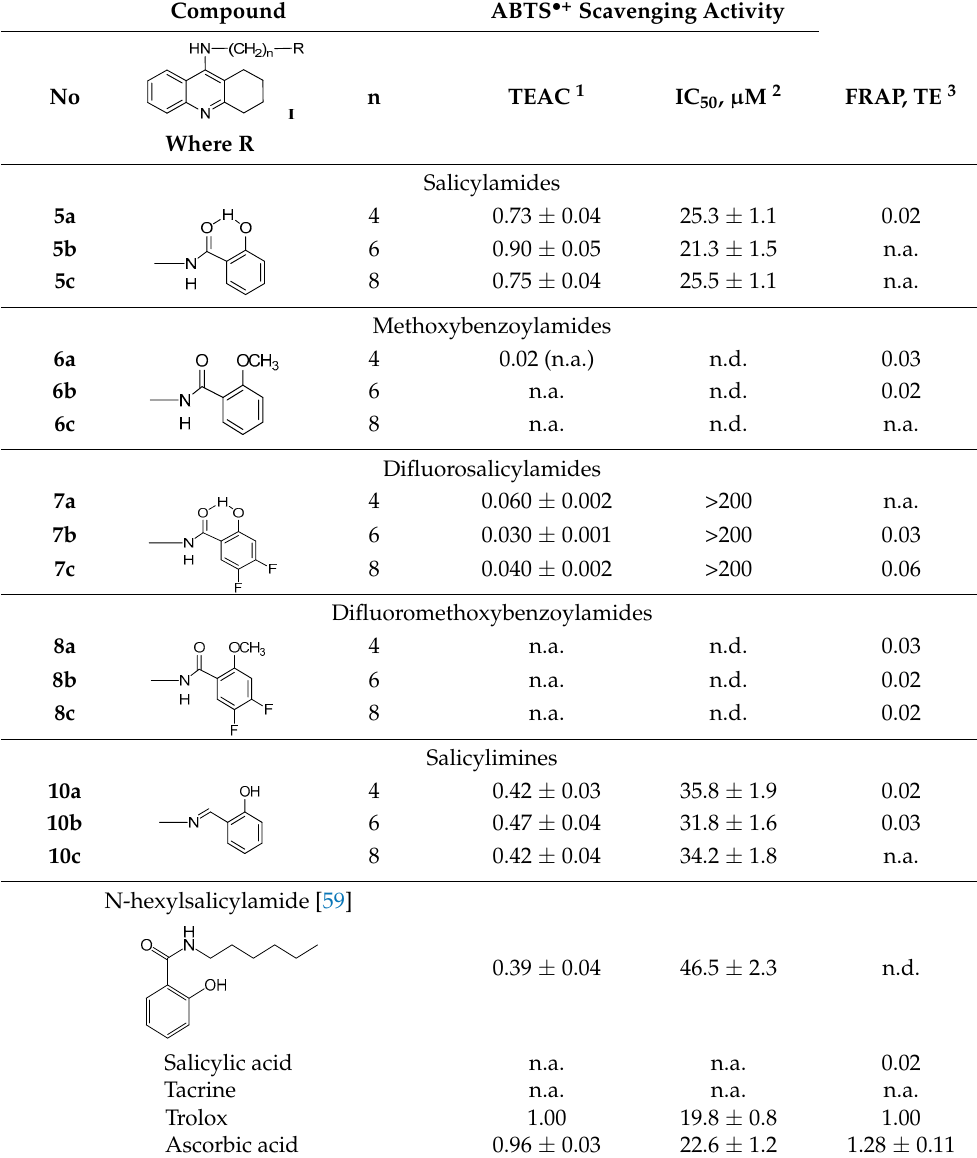
Table 3. AO properties of conjugates 5 – 8 , 10 of general formula ( I ). Compound